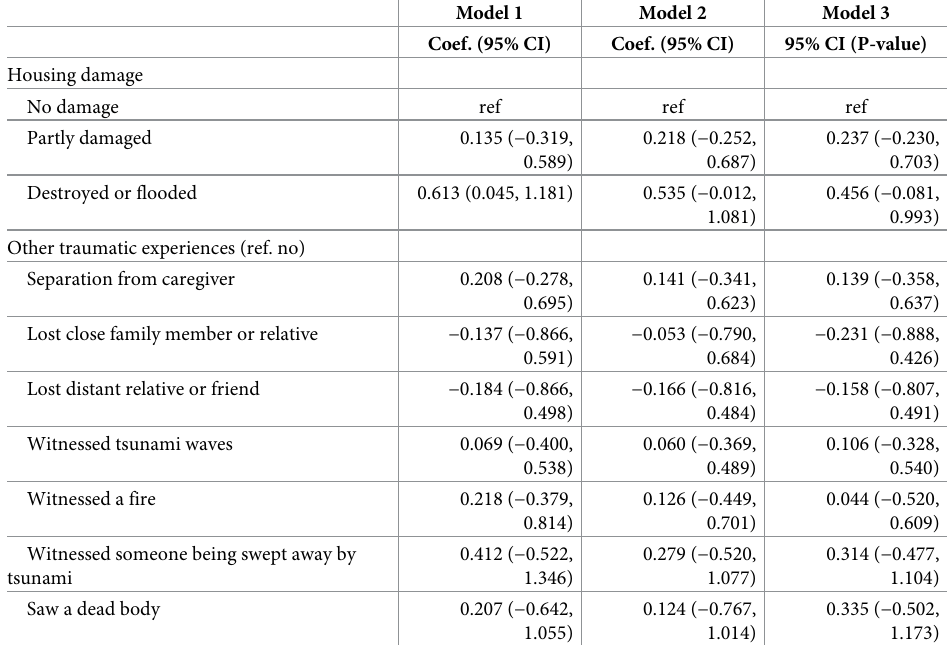
Table 2. Association between traumatic experiences and delay discounting (N =